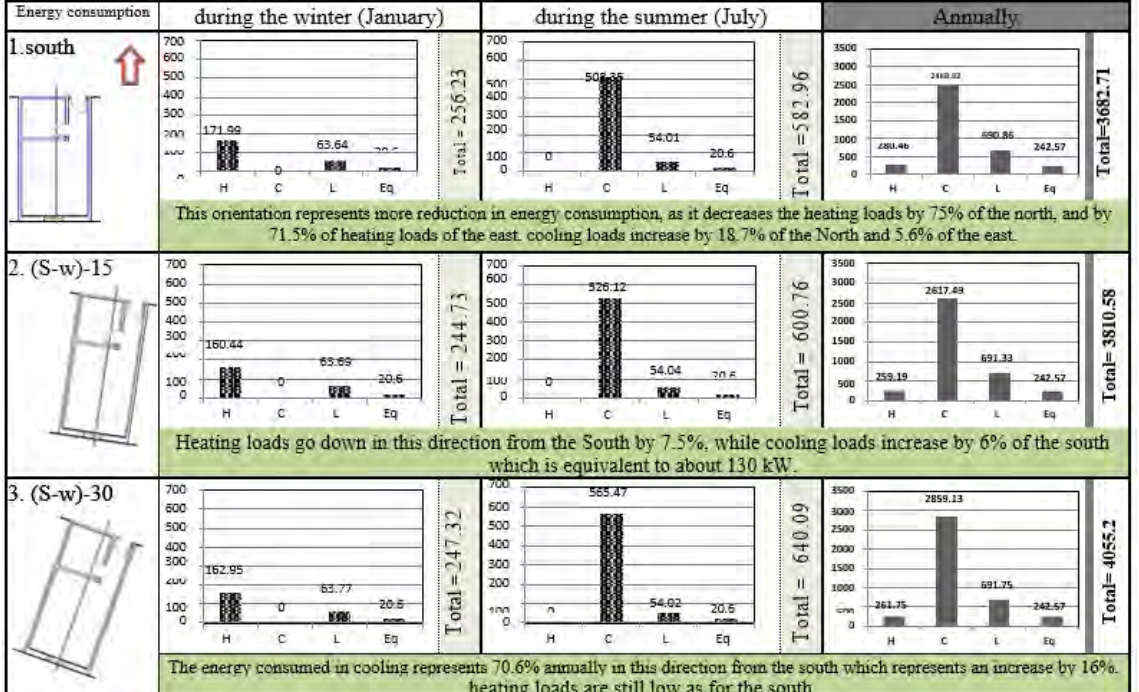
Table 5: Analysis of energy consumption in the directions (east + southeast) annually and during the summer and winter